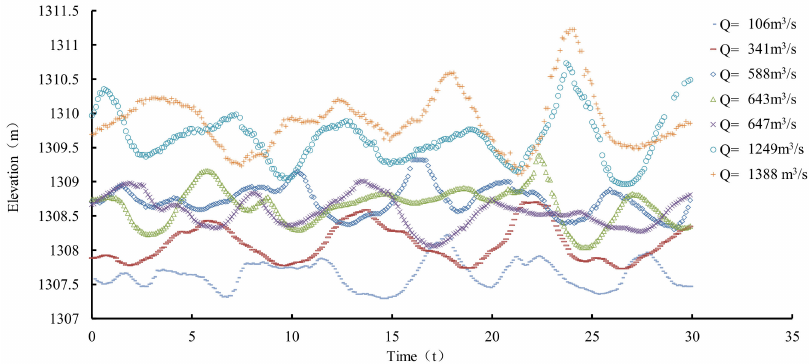
Figure 13. Time series of water surface